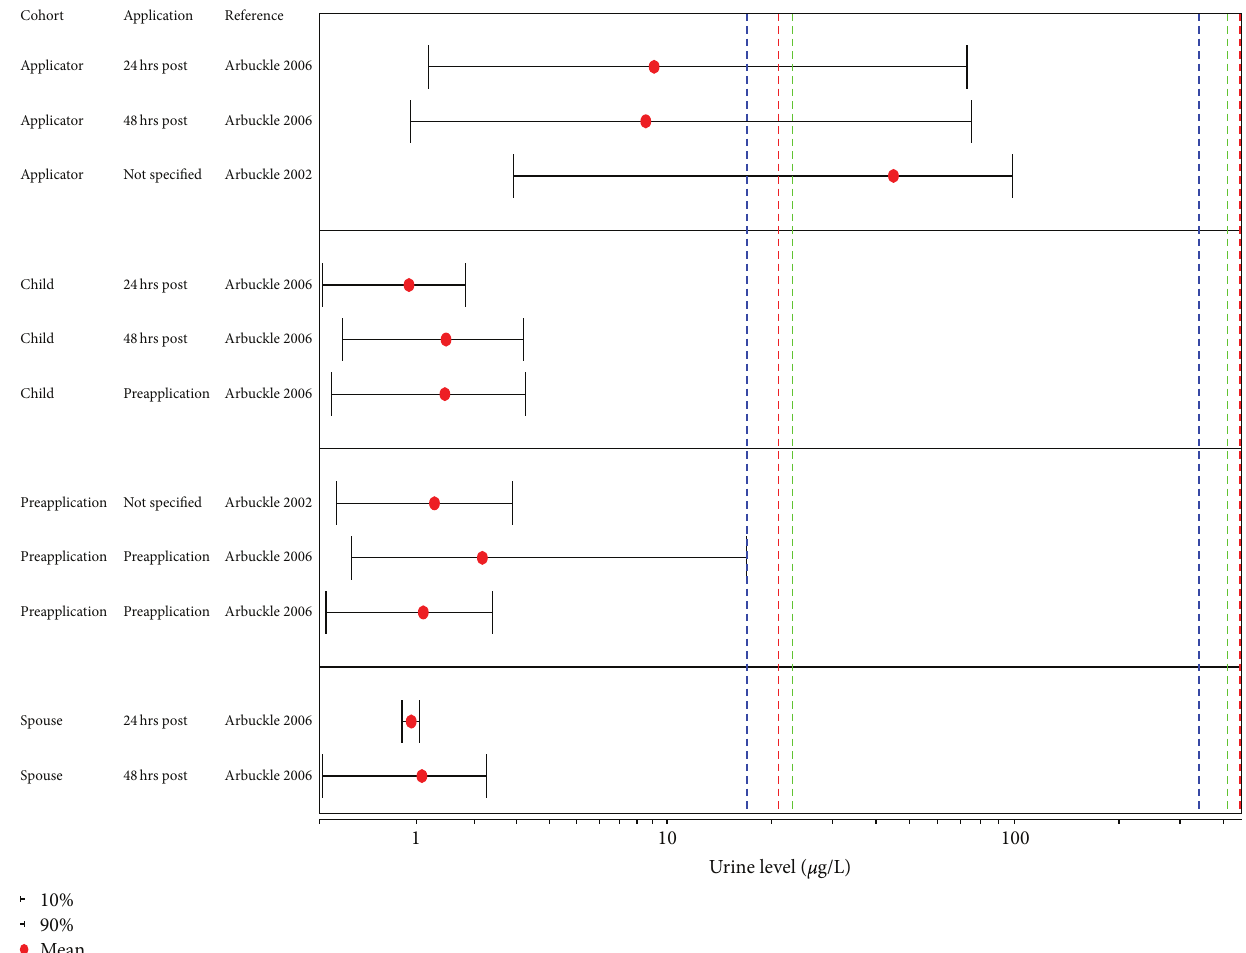
Figure 8: Biomonitoring data for MCPA in the context of backcalculated urine levels. Reference lines: green = men 23 𝜇 g/L (RfD), men 410 𝜇 g/L (ToxCast reverse dosimetry). Blue = women 17 𝜇 g/L (RfD), women 340 𝜇 g/L (ToxCast reverse dosimetry). Red = child 21 𝜇 g/L (RfD), child 450 𝜇 g/L (ToxCast reverse dosimetry) see for review [218,